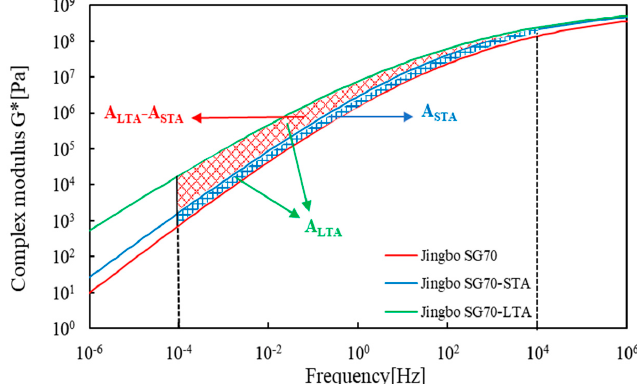
Figure 5. Schematic diagram of the deviation areas of Jingbo SG70 bitumen. Table 6. The horizontal shift factor and deviation area of various bitumen binders.